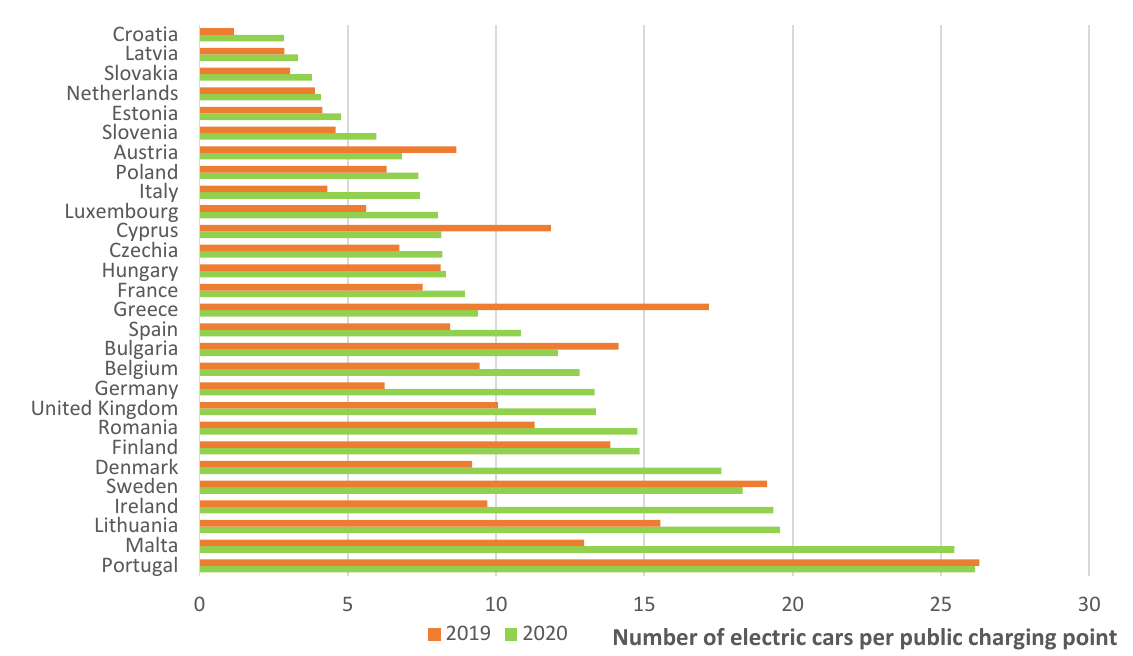
Figure 3. Number of electric cars per public charging point in EU countries in 2019 and 2020. Table 1. Indicators assessing the development of electromobility in EU countries in